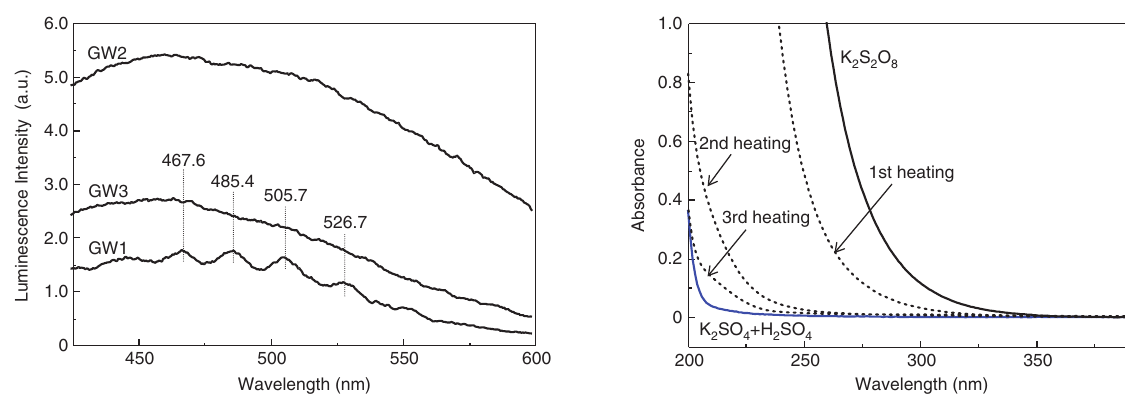
Figure 2 Solid lines represent the absorption spectra for K (0.074 m) and mixed sulfate (0.074 m K solutions, whereas dotted lines represent the decrease of the absorbance of K decomposes into the K